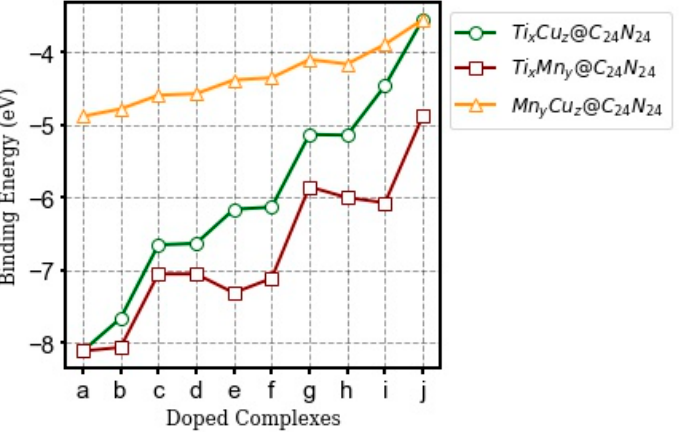
Figure 3. The calculated binding energy (E b ) of Ti x Cu z @C 24 N 24 , Ti x Mn y @C 24 N 24 , and Mn y Cu z @C 24 N 24 (x, y, z = 0–6). a–j refer to the bi-metal configurations with different metal ratios listed in Table 1. All values are in eV.